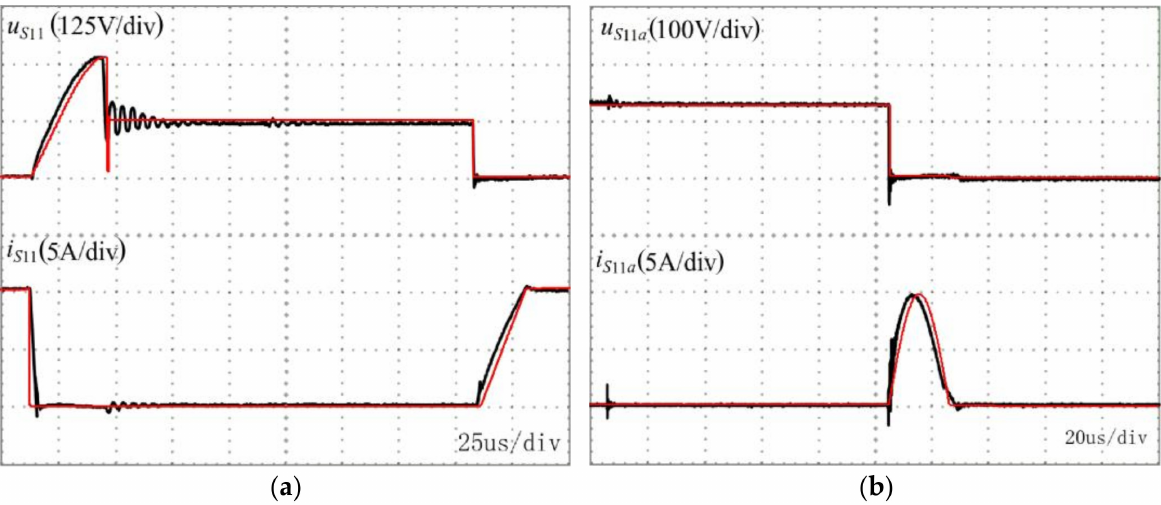
Figure 12. Comparison of measured (black lines) and calculated (red lines) voltage and current waveforms of ( a ) main switch S11, and ( b ) auxiliary switch S11a.